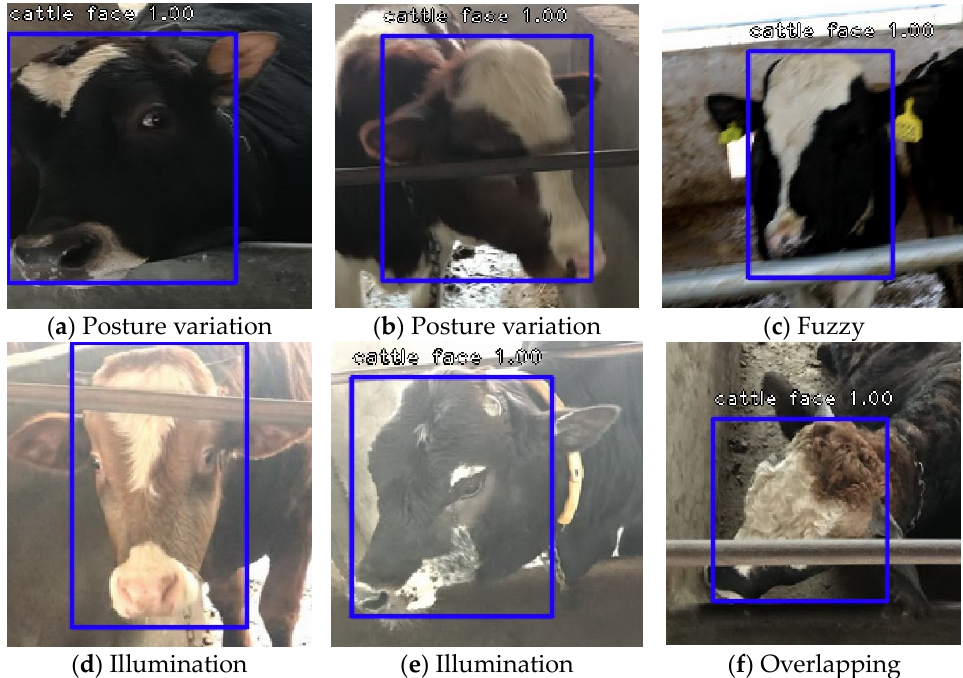
Figure 8. Detection results of cattle faces in various unstructured scenes.